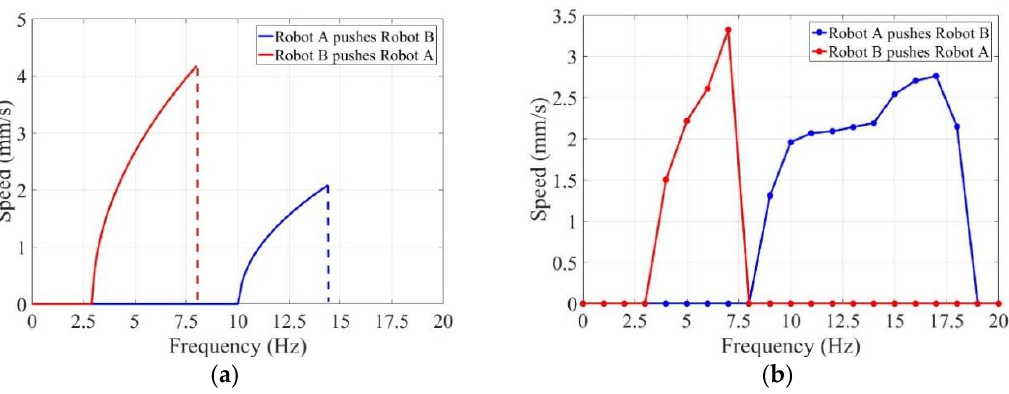
Figure 14. Relationship between axial speeds of the whole and driven frequencies of the rotational electromagnetic field: ( a ) theoretical results; ( b ) experimental results.